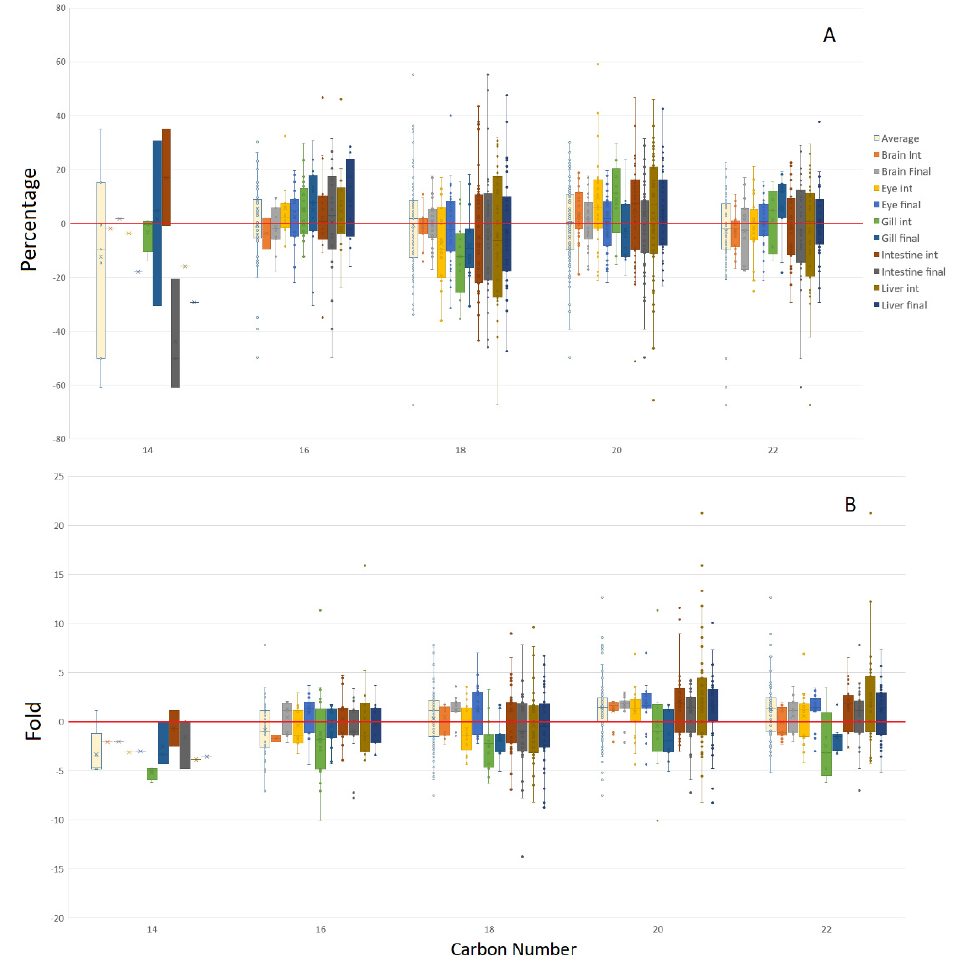
Figure 7. Acyl lipid carbon number bias toward the GM or control diets for combined PC and PE lipid pools represented as a percentage ( A ) or fold data ( B ), with positive values GM biased, and negative values control biased.